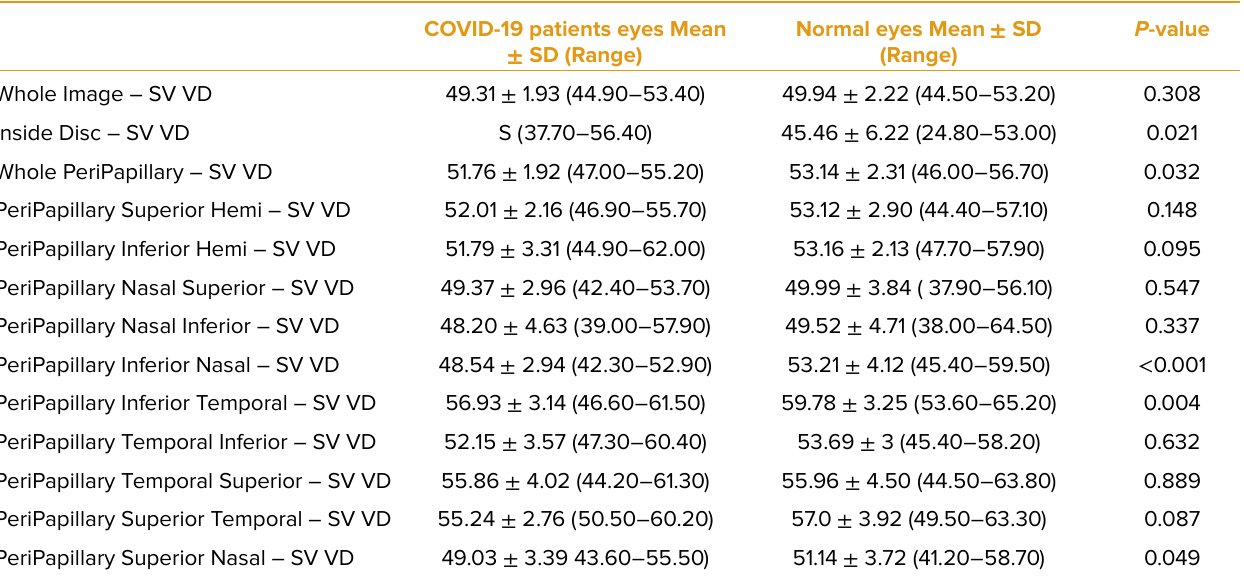
Table 2. Comparison of small vessels (SV) vessel density (VD) of COVID-19 patients eyes versus normal